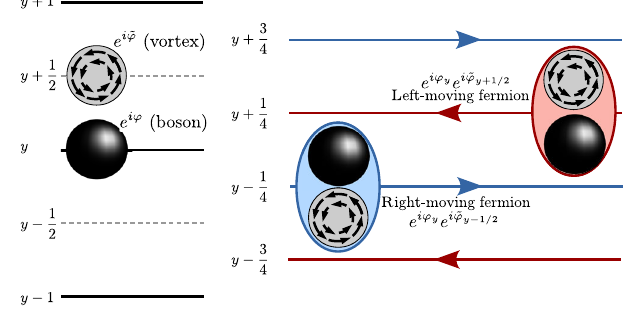
FIG. 8. Composite fermions are constructed by combing a boson with a vortex. With bosons residing on the direct lattice and vortices on the dual lattice, composite fermions are most naturally associated with new quarter-integer lattice. The fermion chirality depends on the relative position of the boson and